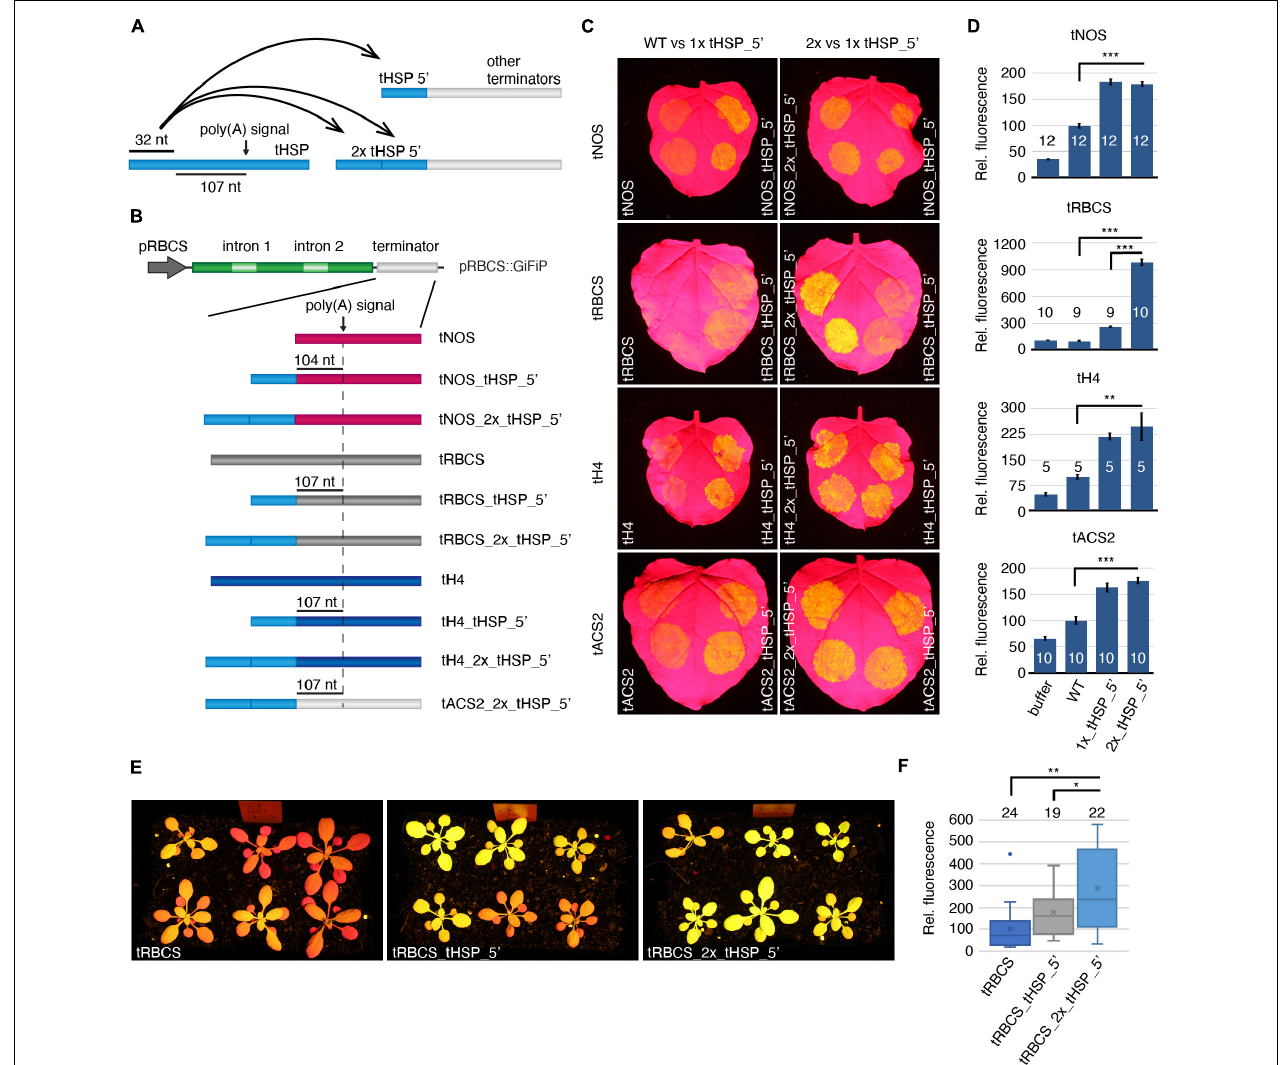
FIGURE 4 | Impact of the tHSP 5 (cid:48) fragment on the activity of different terminators. Illustration of the different approaches (A) and constructs (B) utilized to test the impact of the tHSP 5 (cid:48) end on different terminators. (C) Nicotiana benthamiana agroinfiltrated leaves representing the improvement of GFP expression as a result of the incorporation of one or two copies of the tHSP 5 (cid:48) region into the sequence of different terminators. (D) The relative fluorescence of the reporter under the control of wild-type or chimeric terminators is shown. Values are from independent infiltration spots collected from four (tH4), five (tACS2 and tRBCS), or six leaves (tNOS), each one from a different plant. The exact number of replicates analyzed is indicated for each line (numbers shown in the graph columns). Statistically significant differences between wild-type and chimeric terminators, and between regulatory elements carrying one or two copies of the tHSP 5 (cid:48) fragment are indicated with “**” or “***” for a p -value of p ≤ 0.01 and p ≤ 0.001, respectively (Mann-Whitney U test). (E) GFP fluorescence in 21-days old T1 plants representing a population carrying the wild-type tRBCS compared to chimeric versions containing one or two copies of the tHSP 5 (cid:48) region (tRBCS_tHSP_5 (cid:48) and tRBCS_2x_tHSP_5 (cid:48) , respectively). (F) GFP fluorescence relative to the wild-type tRBCS. The number of plants analyzed is indicated for each group. Statistically significant differences (Welsh t -test; two-sample unequal variance; two-tailed distribution) between wild type and chimeric terminators (“**”; p ≤ 0.01), and between regulatory